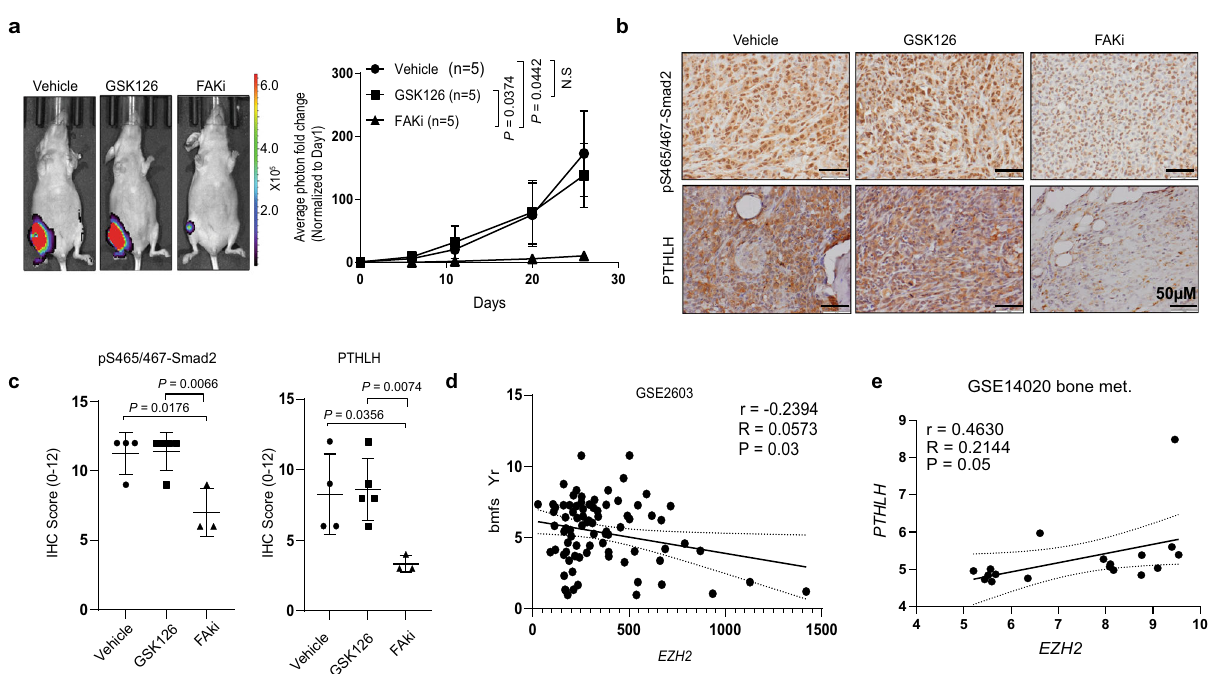
Fig. 6 Treatment with a clinically applicable FAK inhibitor blocks EZH2-induced breast cancer bone metastasis. a Representative bioluminescence images of and quanti fi cation of the fold change in BLI intensity in the right leg region in three subgroups of mice ( n = 5 in each group) intratibially injected with MDA-MB-231 cells and given treatment with a vehicle, GSK126 (100 mg/kg/day, i.p. injection), or the FAKi VS-6063 (50 mg/kg, twice a day, oral gavage) beginning on day 18 of injection. The BLI signal was normalized according to the signal on the fi rst day after injection. Data are presented as means ± S.D. t -test (two-sided). b , c Representative pictures of IHC staining and quanti fi cation of pS465/467-Smad2 and PTHLP expression in the bone metastasis samples obtained from the three subgroups of mice in a . Data are presented as means ± S.E.M. t -test (two-sided). n = 4 bone metastasis slices in vehicle subgroup; n = 5 bone metastasis slices in GSK126 subgroup; n = 3 bone metastasis slices in FAKi subgroup. Scale bars, 50 μ m. d The Pearson r correlation for EZH2 RNA expression and bone metastasis-free survival years (bmfs Yr) in breast cancer patients (GSE2603 dataset). e The Pearson r correlation for EZH2 and PTHLH RNA mRNA expression in bone metastasis samples obtained from breast cancer patients (GSE14020 dataset). All P -values are indicated in the fi